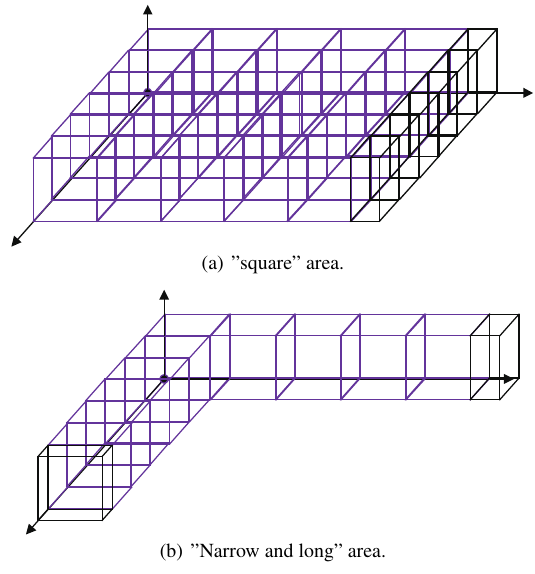
(b) ”Narrow and long” area. Figure 13. Two types of location area rasterized fill figure.